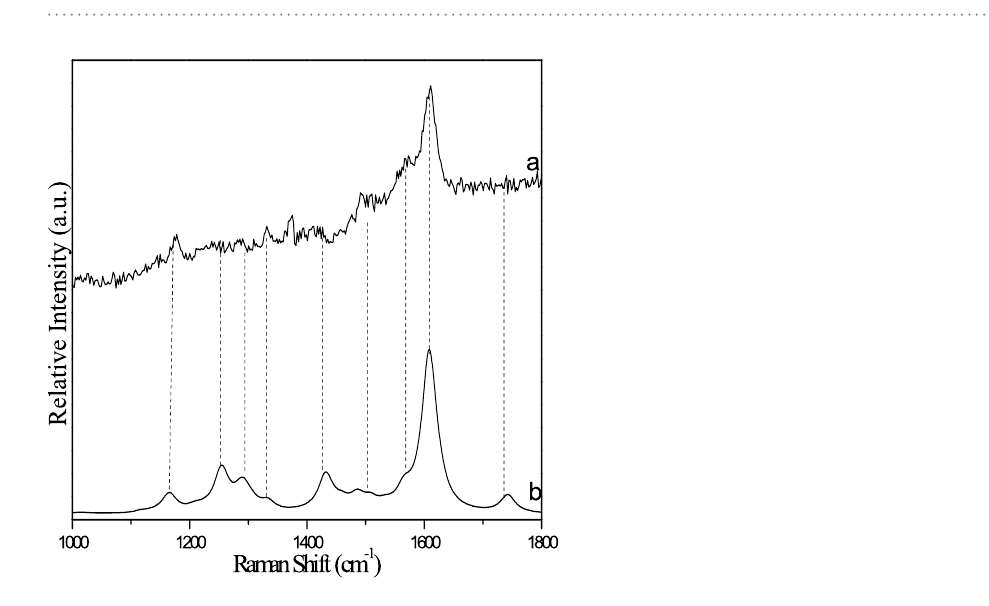
Figure 13. The ns-TR 3 spectra of PPAQ after 266 nm photoexcitation in pH 2 MeCN-H 2 O (1:1) using a 355 nm probe wavelength at various time delays indicated next to the spectra are shown.